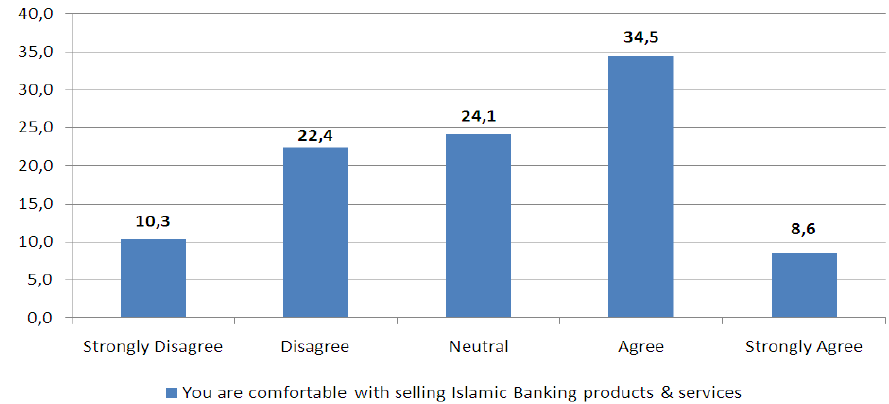
Fig. 5. Are you comfortable with selling Islamic banking products